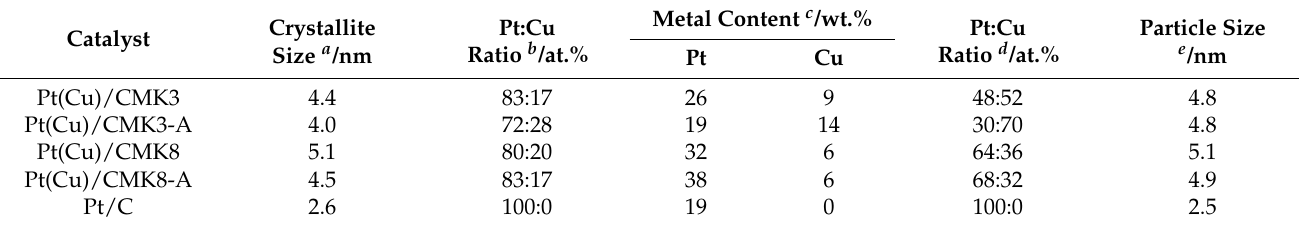
Table 1. Particle size and compositional characteristics of the supported Pt(Cu) catalysts obtained from XRD and EDS analyses and TEM observations. Catalyst